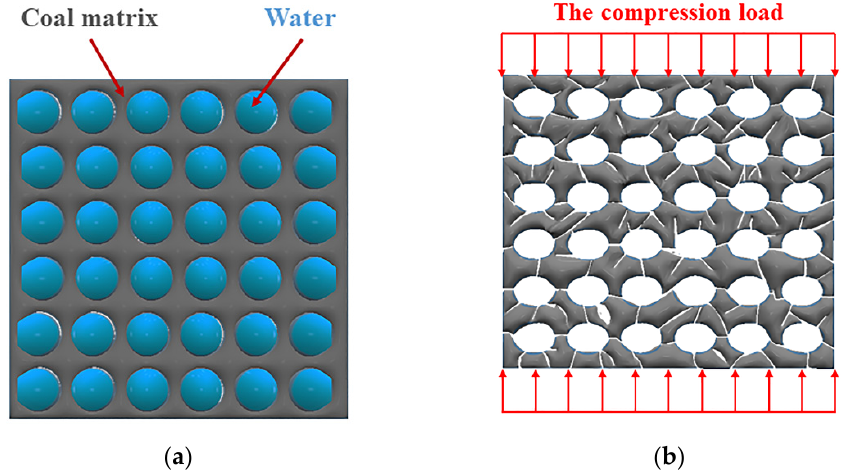
Figure 6. A diagram of the water filling and compression failure of the coal micro-pore structure. ( a ) Water filling of pore structure; ( b ) compression failure of pore structure.